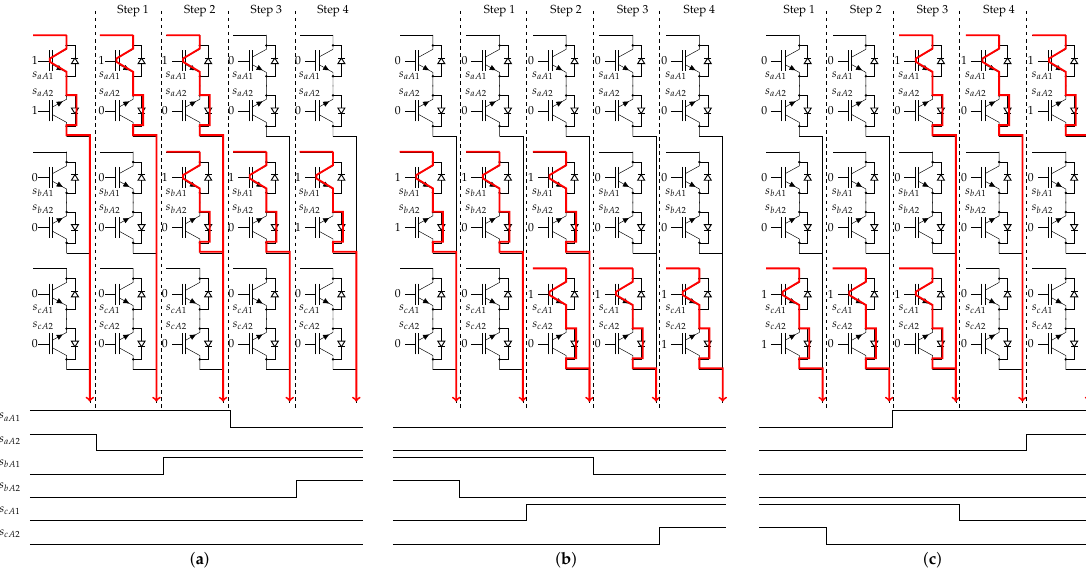
Figure 6. Four-step commutation logical signals, outgoing current case, for the transitions ( a ) s aA to s bA , ( b ) s bA to s cA , and ( c ) s cA to s aA